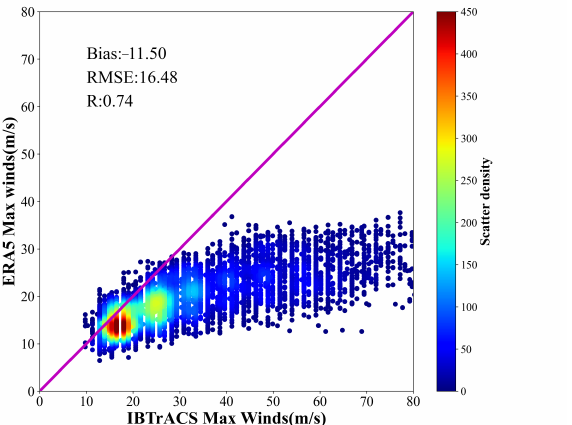
Figure 3. Box and whiskers plots of position deviation among each intensity categories.